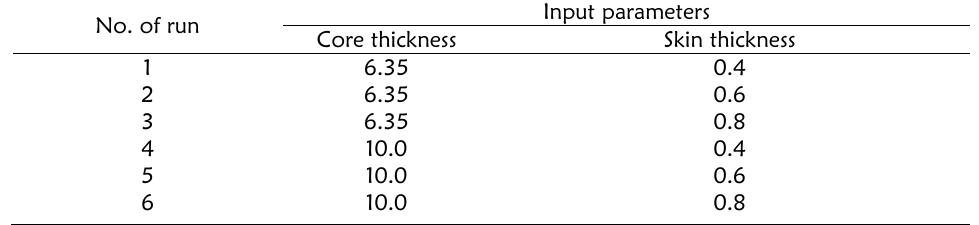
Table 1: Design of experiment for